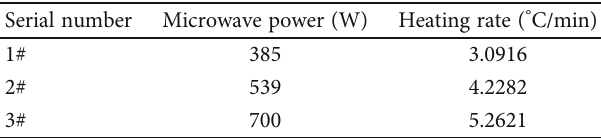
Figure 15: The experimental heavy oil recovery rate curves of each group under di ff erent mass fractions of Table 5: Di ff erent microwave power experiment heating rate.